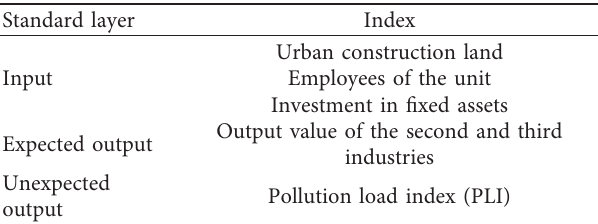
Table 2: Evaluation index of green utilization efficiency of urban construction